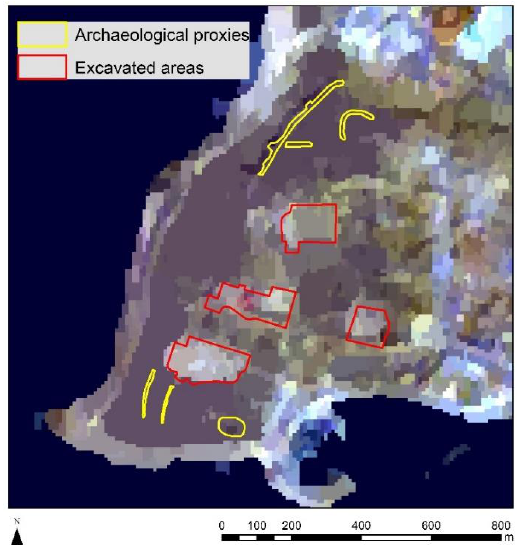
Figure 8. Various ground truth areas digitized for the needs of the segmentation performance of the fused Landsat image. In the background, the Gram–Schmidt pansharpened Landsat 8 image using the NIR band of Sentinel is shown.